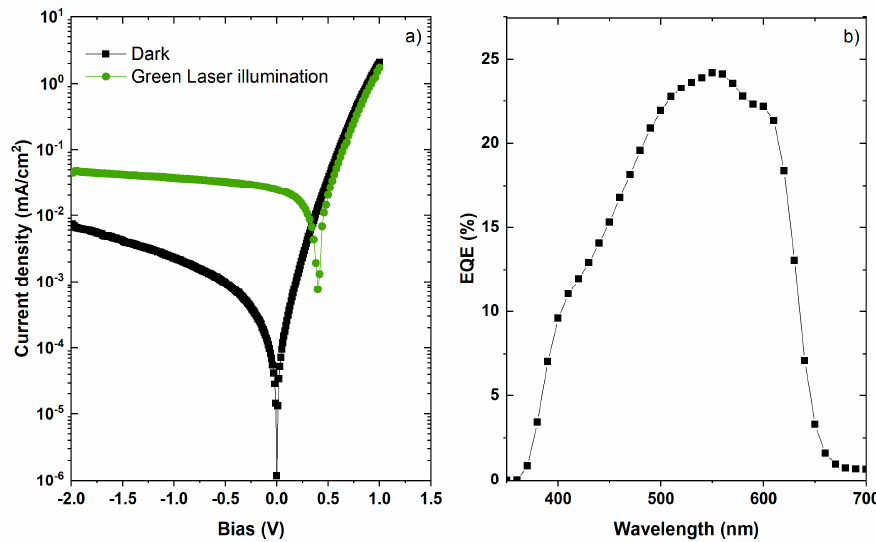
Figure 6. ( a ) J-V characteristic in dark and under green-laser illumination (532 nm); ( b ) EQE at zero bias.